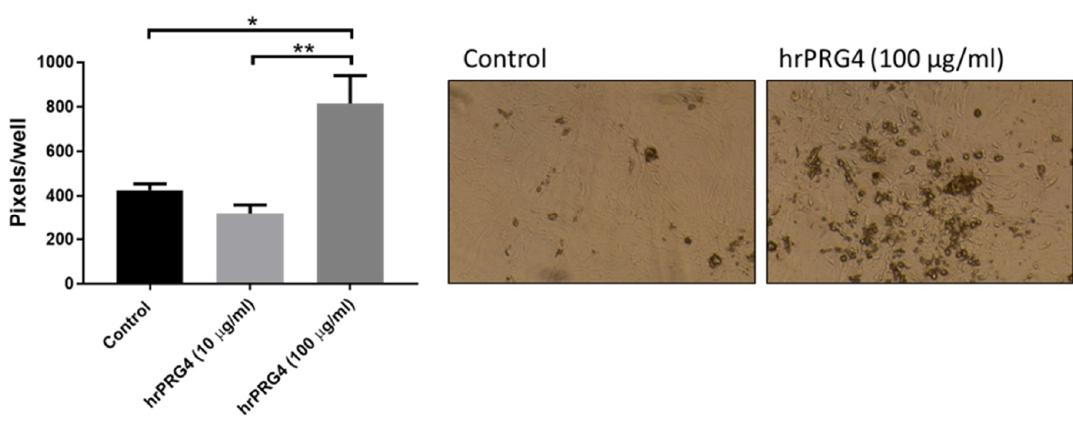
Figure 5. Quantification calcification after 9‐day culture of VICs in the presence of either 2.6 mM inorganic phosphate (control) or 2.6 mM inorganic phosphate with addition of recombinant human proteoglycan 4 (rhPRG4) and representative photomicrographs (N = 4): Statistical significance was determined using a 1‐way ANOVA repeated measurements followed by a Tukey post hoc multiple comparisons analysis; * p < 0.05 and ** p < 0.01.